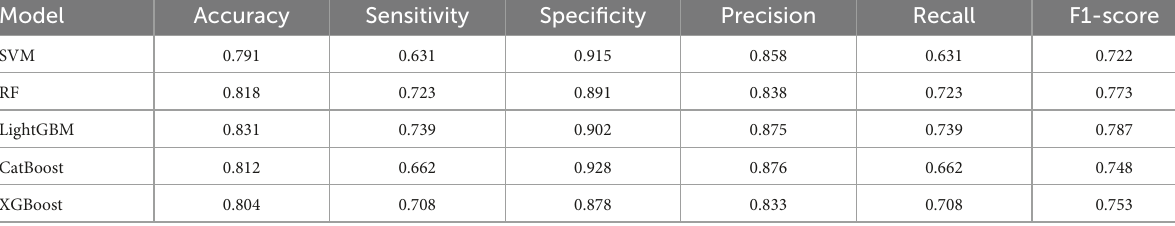
TABLE 3 Results of different models for the test set (average results of five-fold).